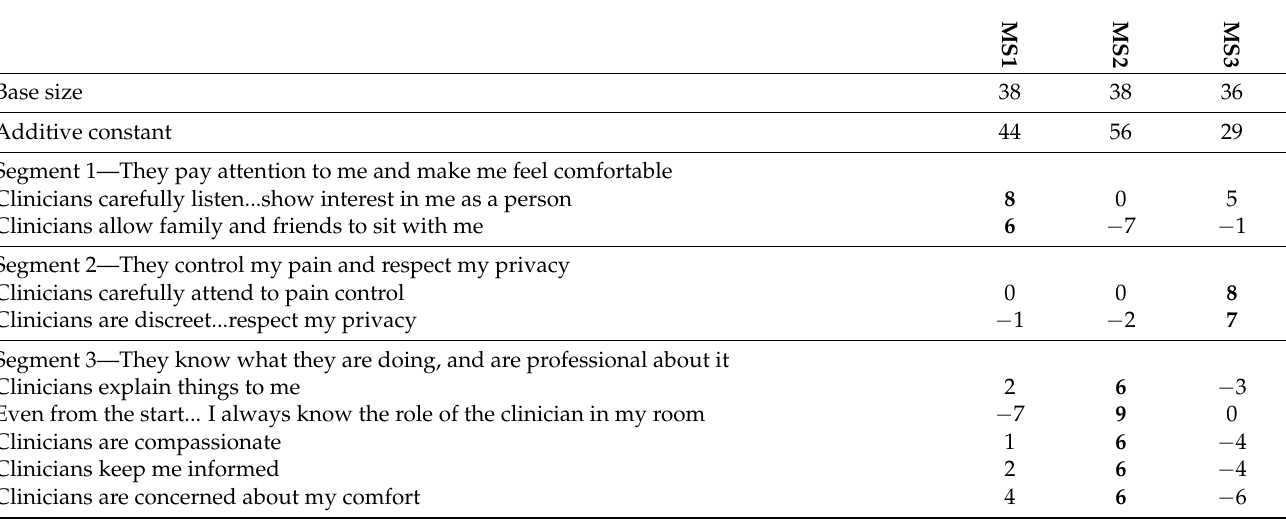
Table 4. Mindset-Segmentation (MS) for Drivers of Satisfaction with Clinician-Patient communication in the Emergency Department and Post hoc ANOVA